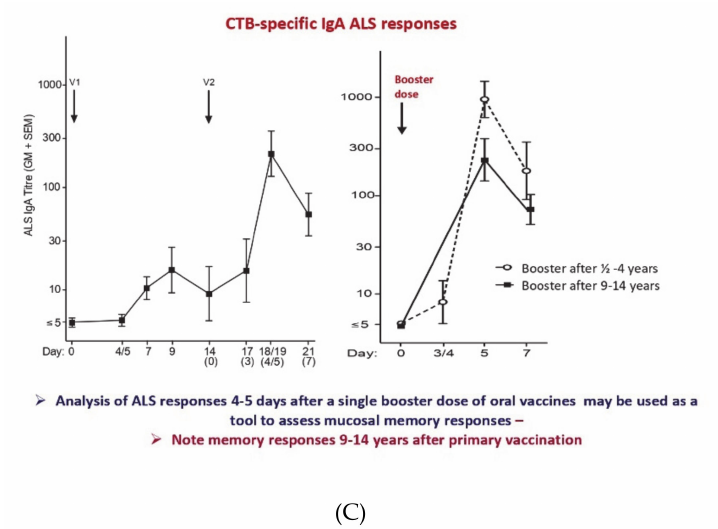
Figure 3. Intestinal IgA antibody responses and immunologic memory in cholera after oral immu- nization or infection. ( A ) IgA antibody responses to cholera toxin (B subunit) and LPS O antigen in intestinal lavage from adult Bangladeshi volunteers after cholera disease and/or immunizations with a B-subunit/whole-cell cholera vaccine that was administered orally (PO) or intramuscularly (IM) at an interval of 28 days. Two oral vaccine doses (in which the B subunit amounts were either 2.5 or 0.5 mg) induced antitoxin and anti-LPS intestinal IgA responses that were fully comparable to those measured after disease; in contrast, the IM route was ineffective. Adjusted from [16]. ( B ) Intestinal immune response kinetics in Swedish healthy adults after a first and second primary immunization with oral B subunit/whole-cell cholera vaccine (Dukoral) and after a single booster dose 5.5 months later; immune responses were examined as specific anti-B subunit antibody-secreting cells (ASC) in mononuclear cells (MNC) that were isolated from duodenal mucosal biopsies at various time points. Adapted from [22]. ( C ) Long-lasting immunologic memory to cholera B subunit found in Swedish adult volunteers for at least 9–14 years after an initial two-dose immunization regimen